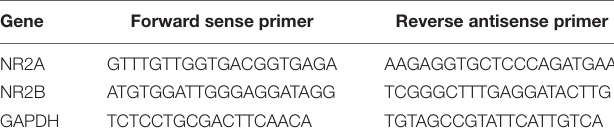
TABLE 2 | Primer sequences used for real-time PCR